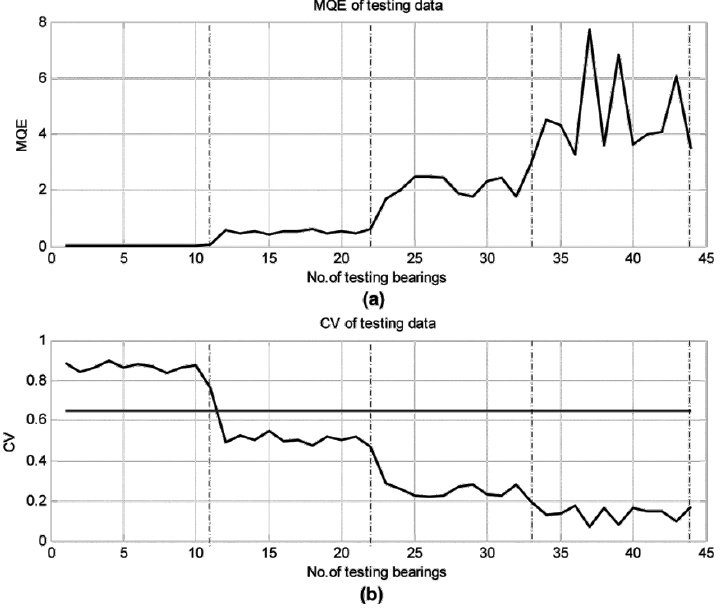
Fig. 10. Bearing health assessment of different fault degrees (inner-race fault), (a) Using MQE (b) Using CV. of 0.028 inches, were selected and sequentially imported into the trained SOM-based health assessment model. The performance assessment results are shown in Fig.